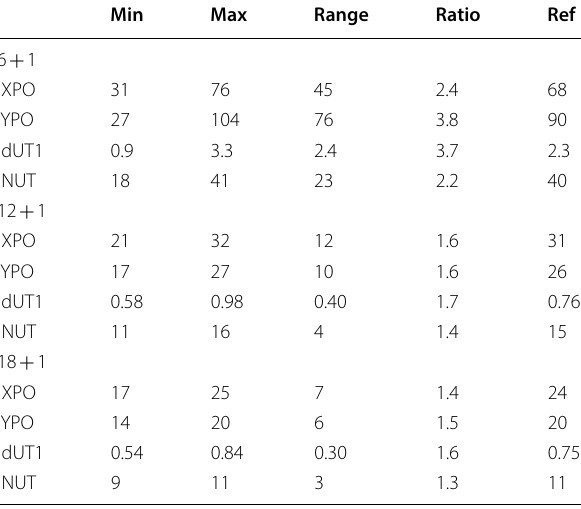
and maximum simulated EOP repeatability over all variable antenna locations, as well as their range and ratio in µ as and µ s,